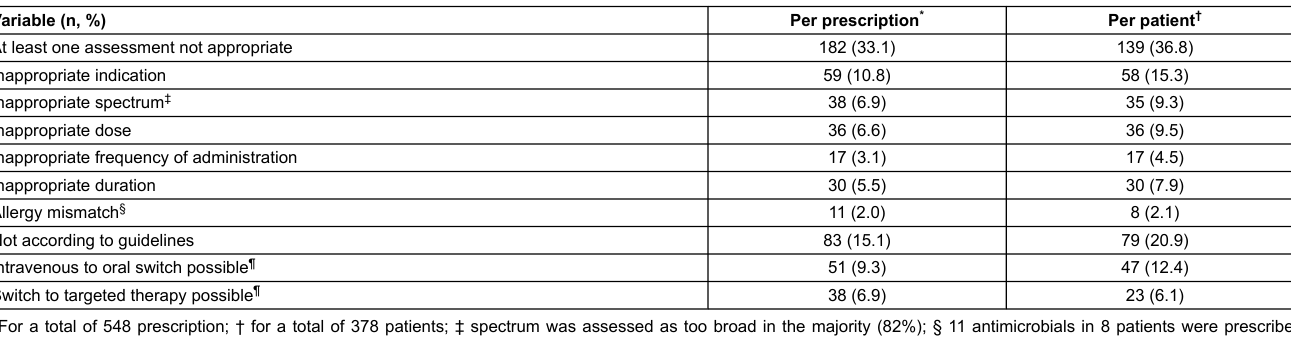
Table 3: Assessment of inappropriateness per prescription and per